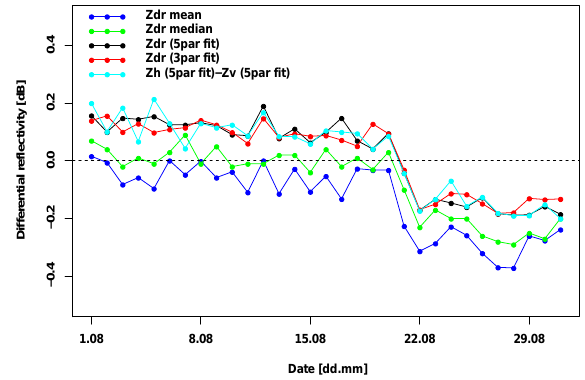
Figure 6. Solar Z dr values with system Z dr bias subtraction for the ANJ radar in August 2014. The methods are indicated in the figure. The downward step on 21 August is a result of the change of the system Z dr bias.